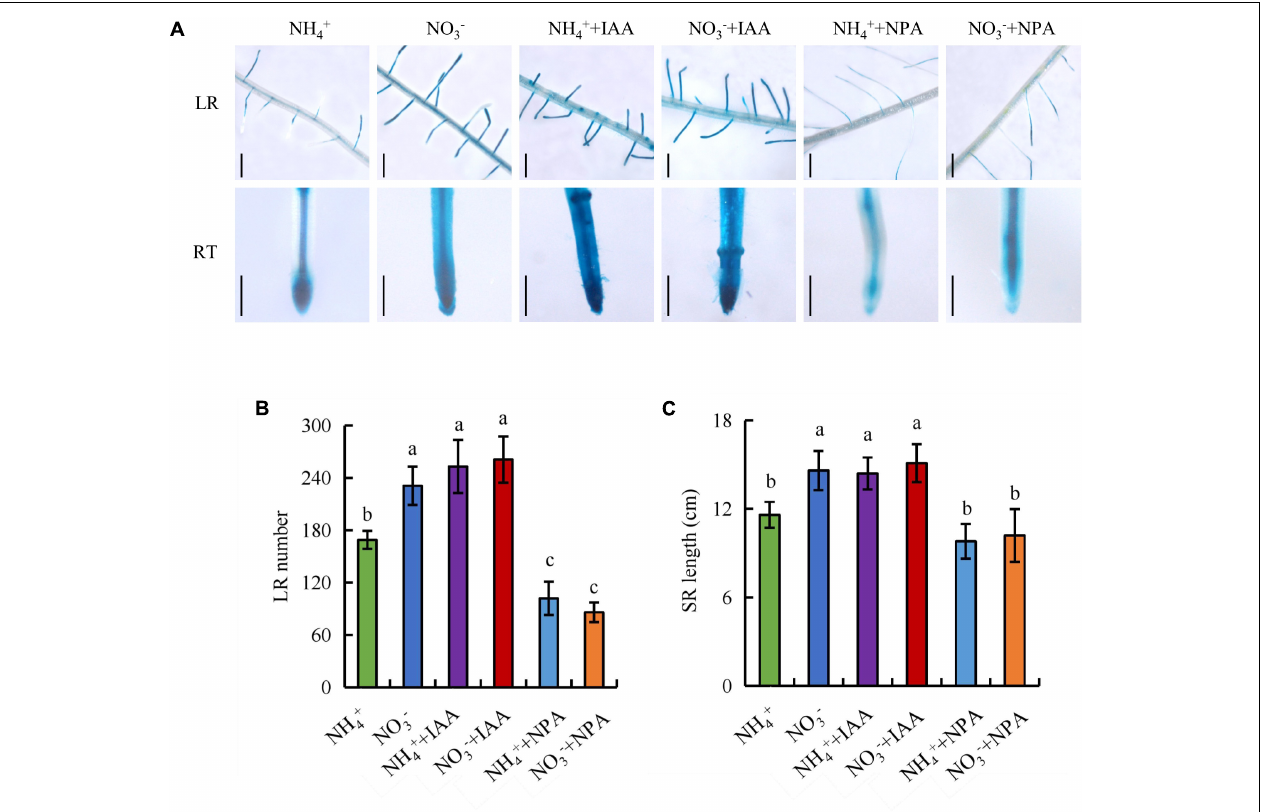
FIGURE 6 | DR5::GUS activity and root morphology in wild-type (DJ). Seedlings were grown in hydroponic medium containing NH 4 + and NO 3 − in addition to IAA (100 nM) and NPA (300 nM) for 14 days. (A) , DR5::GUS activity in the lateral root zone (LR) and root tip (RT); (B) , Lateral root (LR) number; (C) , Seminal root (SR) length. Bar = 1 mm. Data are means ± SE and bars with different letters indicate significant difference at P < 0.05 tested with